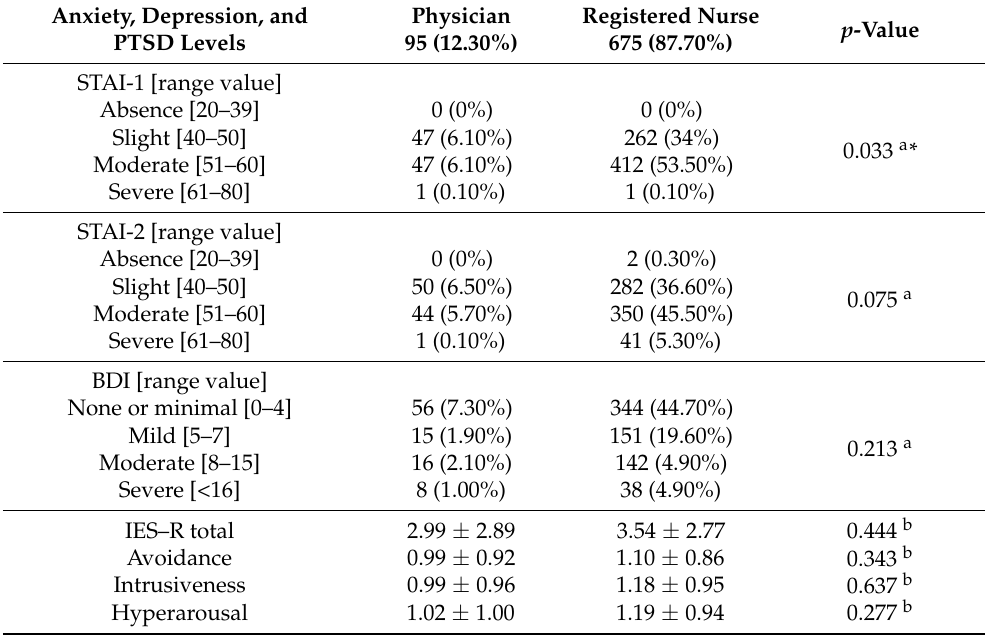
Table 2. Anxiety, depression, and PTSD levels among physicians and